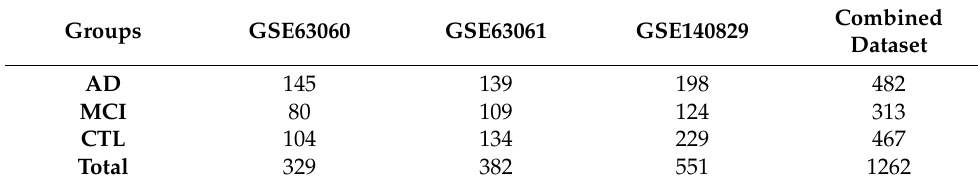
Table 1. Gene expression datasets used in the study. There are 29,958 probes in GSE63060; 24,900